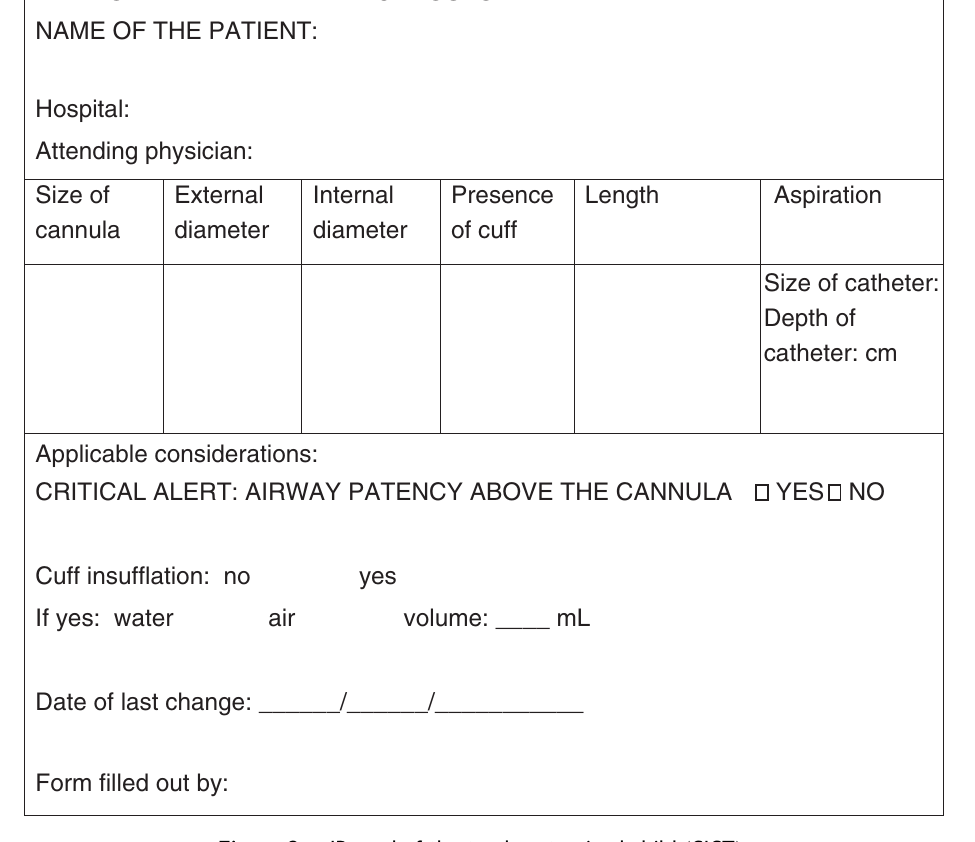
ID card of the tracheostomized child